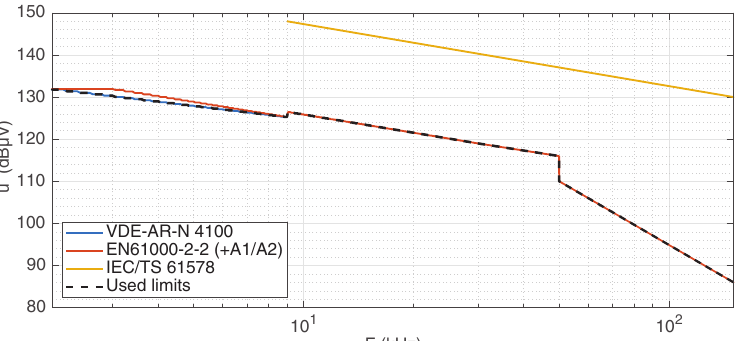
Figure 8. Comparison of grid code voltage limits for the frequency range of 9–150kHz. For